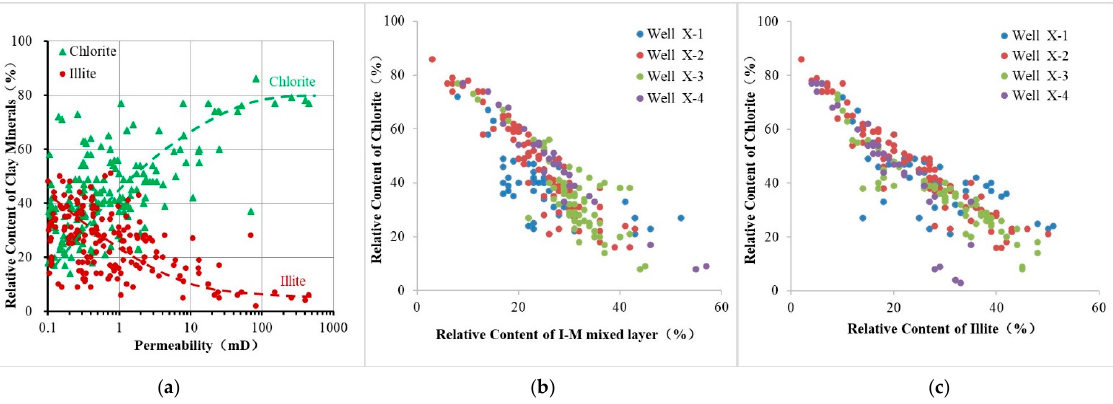
Figure 3. Correlation between main clay minerals of the X gas field and their relationship with petrophysical properties. ( a ) Correlation between relative content of clay minerals and permeability; ( b ) Correlation between relative content of I-M mixed layer and Chlorite; ( c ) Correlation between relative content of Illite and Chlorite.